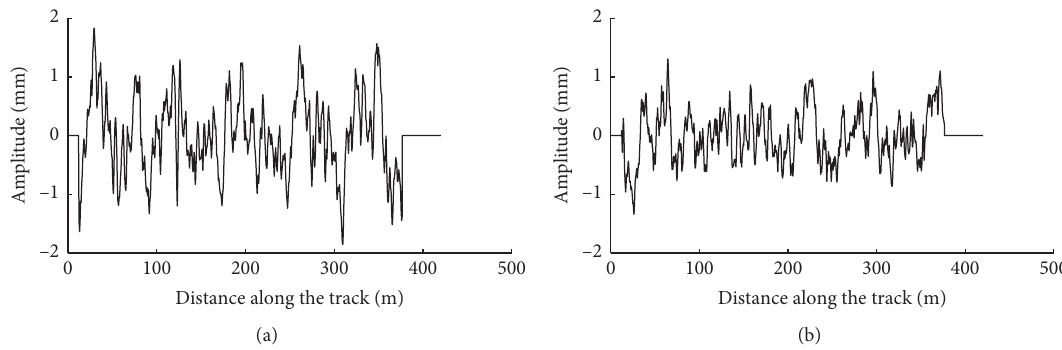
Figure 12: Track irregularities used in the dynamic model. (a) Vertical irregularity; (b) lateral